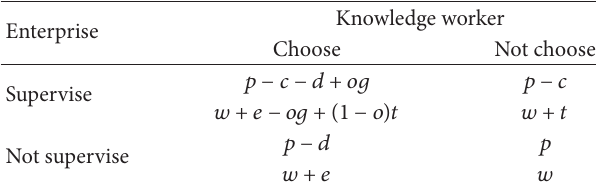
Table 1: Payoff matrix of